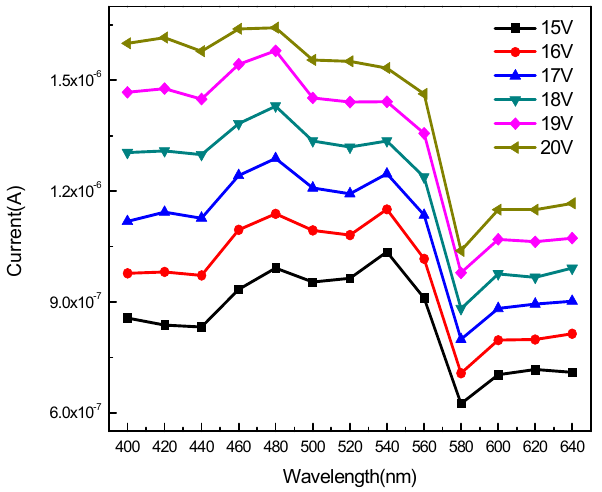
Figure 9. Current and wavelength curve MSM-MAPbBr 3 crystal photodetectors.